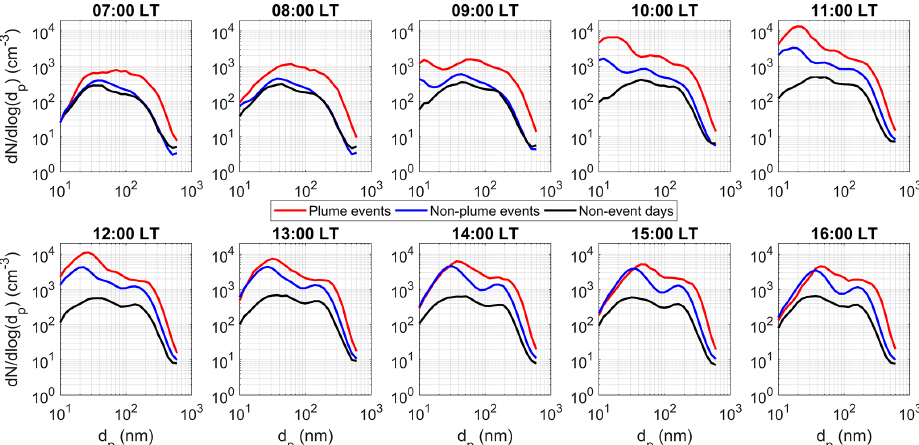
Figure 6. Hourly medians of the particle size distribution derived from DMPS measurements conducted in the different conditions (non- plume NPF event and non-event days, plume NPF event days) between 07:00 and 16:00LT.